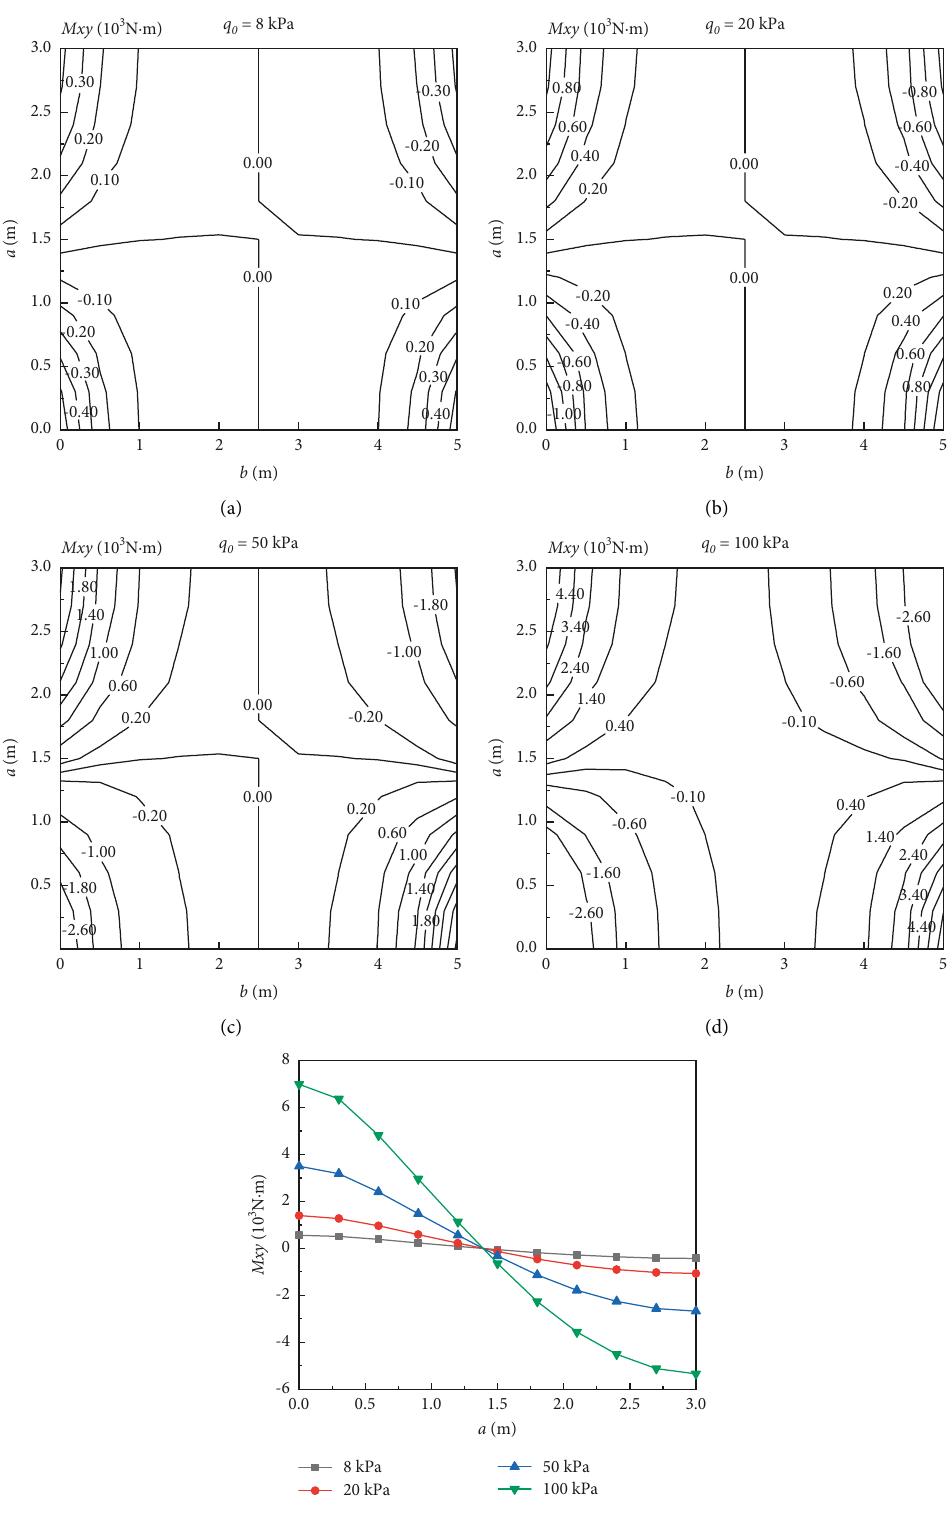
Figure 9: Effect of frost heaving force on bending moment M